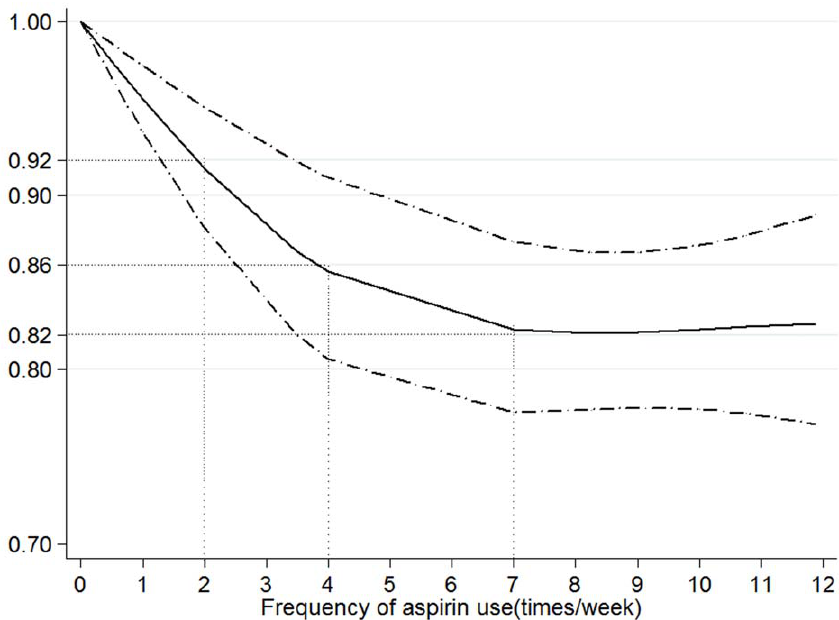
Figure 4. Association between frequency of aspirin use and risk of colorectal cancer obtained by spline regression with 3 knots (0, 3.5, 10.5 times per week) and 0 times per week as reference. P non-linearity =0.007. Solid line represents the estimated relative risk and the dot- dashed lines represent the 95% confidence intervals. The dotted lines are used to explain the relative risk of colorectal cancer for different frequency of aspirin use (RR=0.92, 95% CI 0.88–0.95, for twice per week; RR=0.86, 95% CI 0.81–0.91, for 4 times per week; RR=0.82, 95% CI 0.78–0.87, for 7 times per week; RR=0.82, 95% CI 0.78–0.87, for 10 times per week).